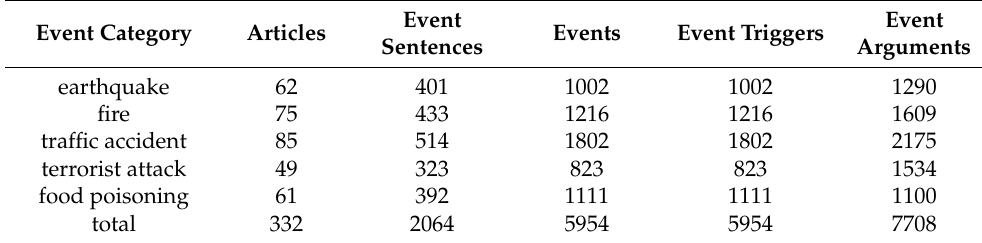
Table 1. Basic information of CEC.